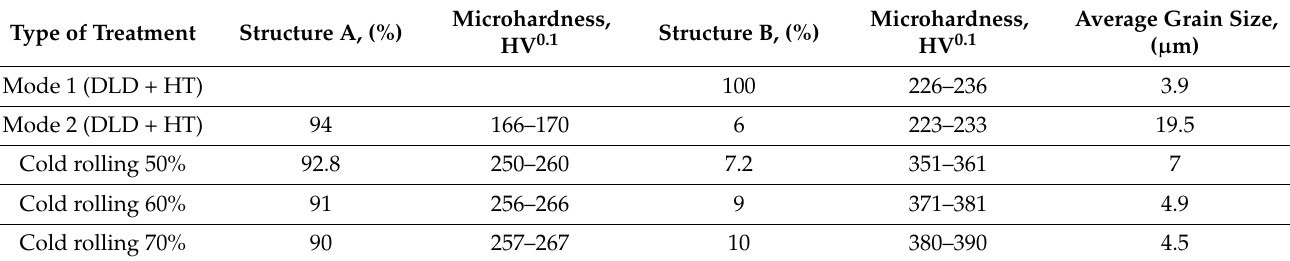
Table 2. Structural components of the obtained samples.